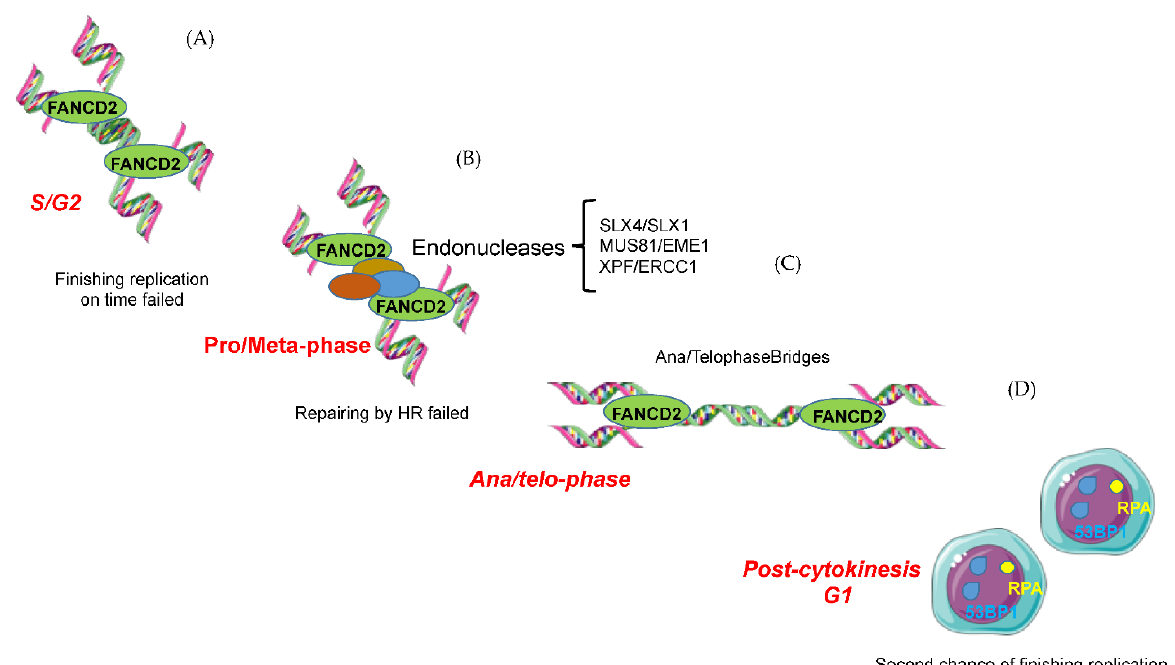
Figure 4. The role of FANCD2 in rescuing under-replicated regions throughout the cell cycle. ( A ) Upon replication stress during S phase, FANCD2 is recruited to the chromatin, as twin foci, to activate downstream repair pathways. ( B ) However, cells can still enter mitosis with under-replicated regions. Thus, to cleave under-replicated/untangled DNA, endonucleases are recruited between the chromatin-bound FANCD2 foci. ( C ) If left uncut/unrepaired, under-replicated chromatids will remain entangled forming ana/telophase bridges during chromosome segregation. ( D ) Unresolved anomalies in under-replicated regions covered by FANCD2 will be covered by RPA or 53BP1 to be protected in the next G1 and actively replicated in the next S phase.